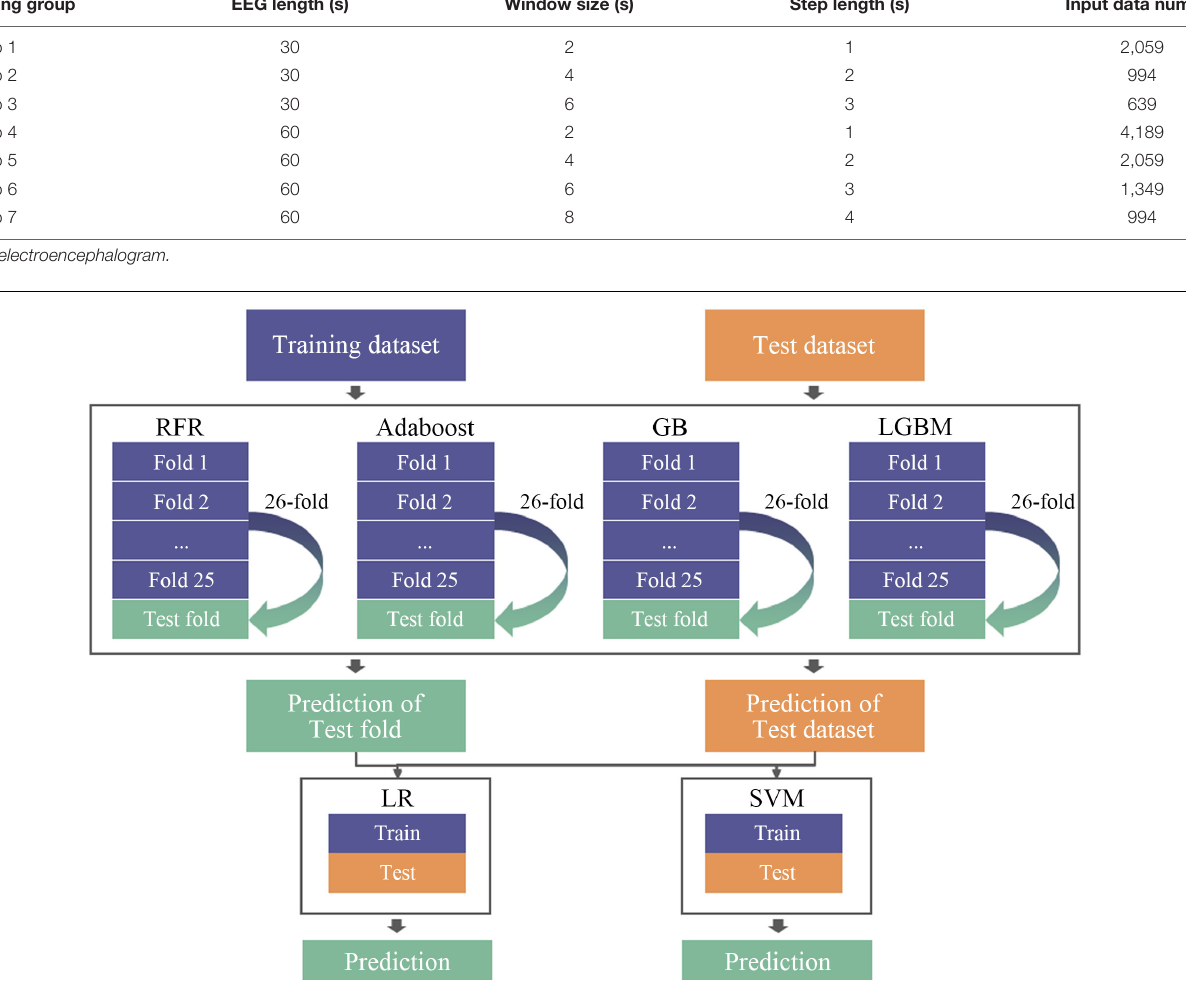
FIGURE 6 | The stacking model